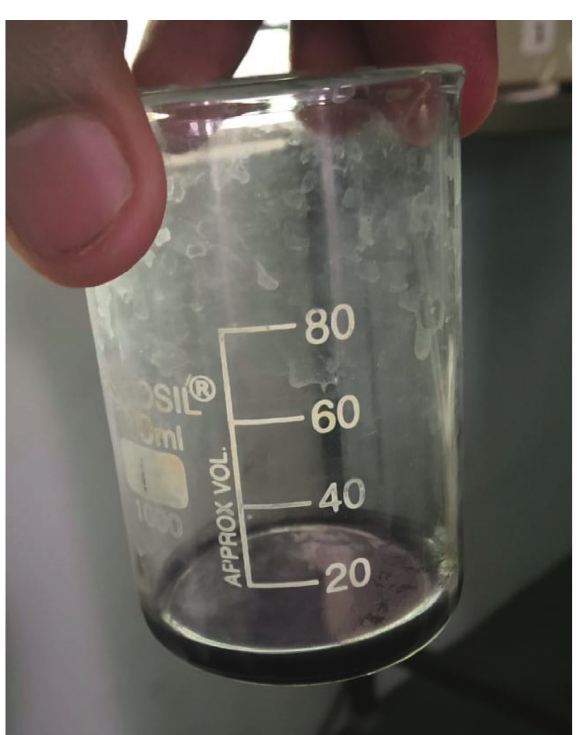
Figure 4: Nanoparticles settled down after 8